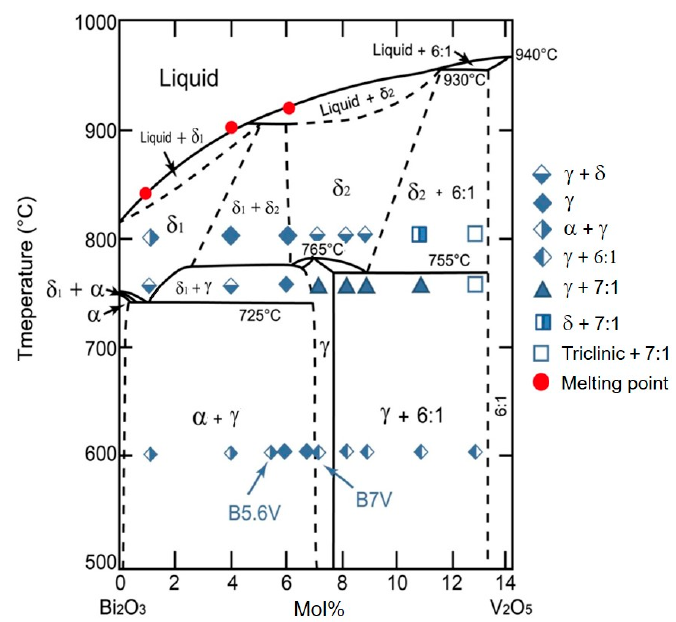
Figure 5. The Bi 2 O 3 -V 2 O 5 phase diagram with the V 2 O 5 doping concentration less than 14 mol%.